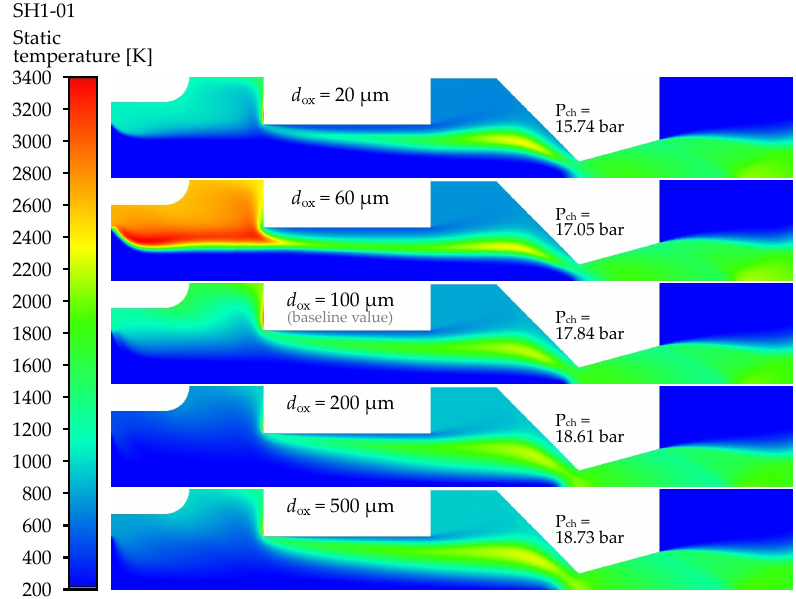
Figure 19. Influence of the oxidizer droplets diameter d ox on the flowfield for case